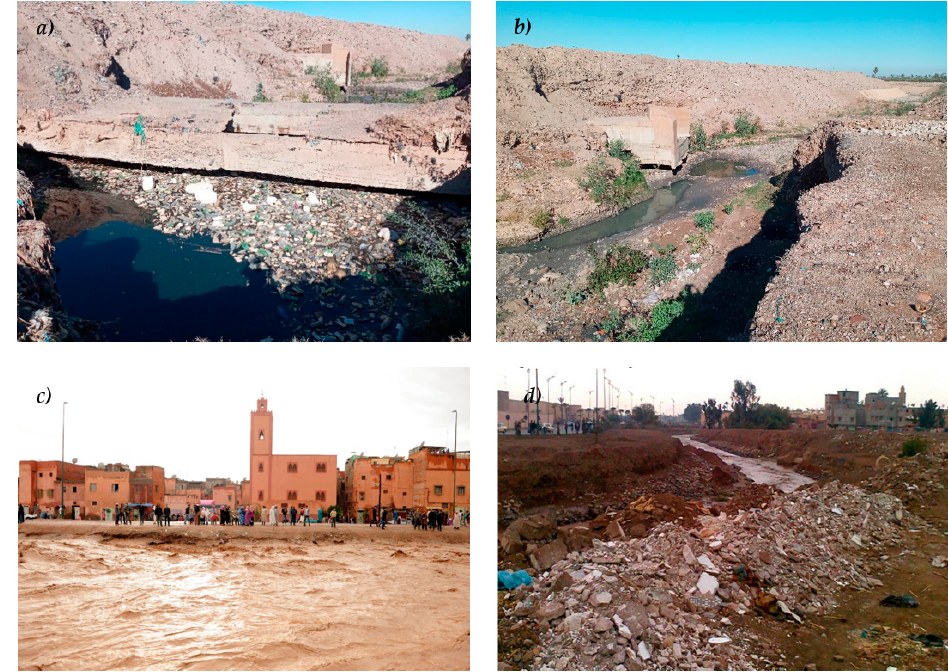
Figure 10 . Photos of Issil River: ( a , b ) infrastructures and waste causing water retention; ( c ) Issil River during a peak flow (euneighbours.eu); ( d ) clandestine waste disposal along the Issil River [35].